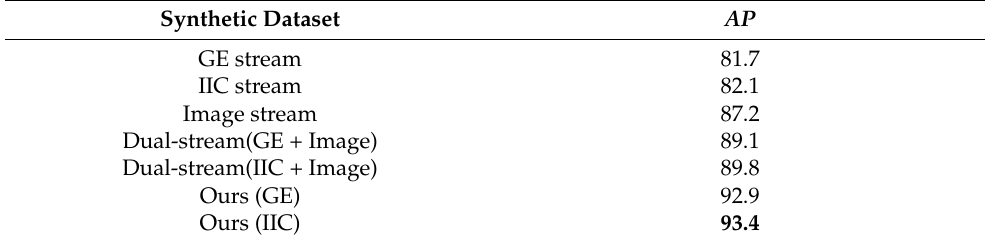
Table 2. Ablation experiments results of AP on synthetic dataset (%).